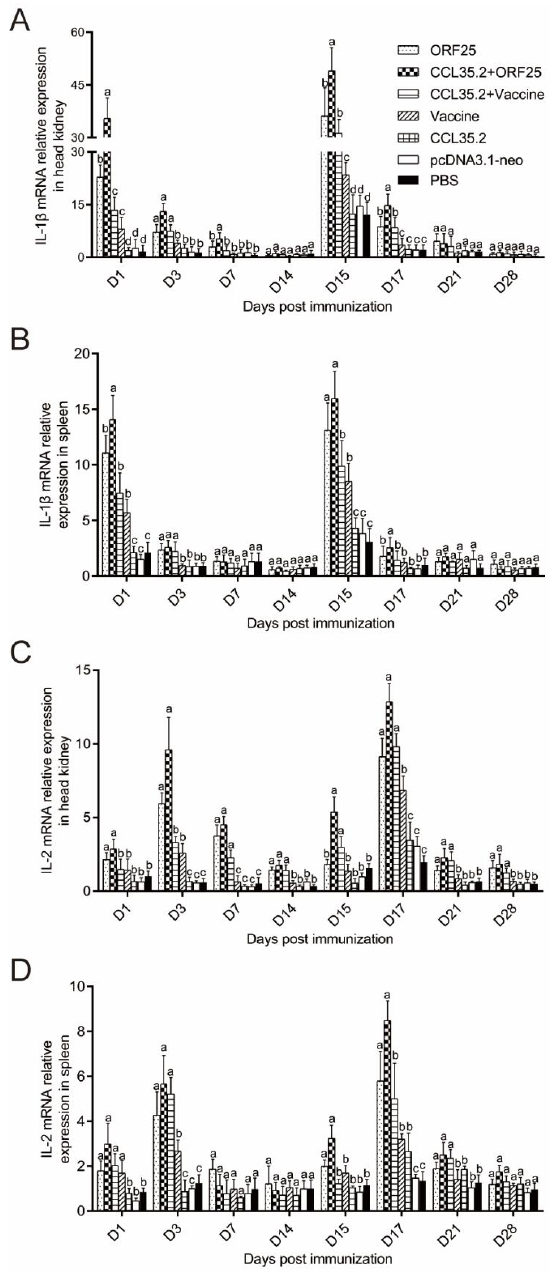
Figure 7. mRNA expression patterns of representative important immune regulation and e ff ector genes in head kidney and spleen tissues. IL-1 β ( A , B ), IL-2 ( C , D ) transcripts were examined by qRT-PCR. β -actin gene was used as an internal control gene. Di ff erent superscript letters in each group (a–d) denote significant variations suggested by the Kruskal–Wallis statistics at 95% of significance, followed by the Dunn test with Bonferroni adjustment as the post hoc test ( p < 0.05). 3.5. Immune Gene Expression was Significantly Upregulated by pcORF25 / pcCCL35.2